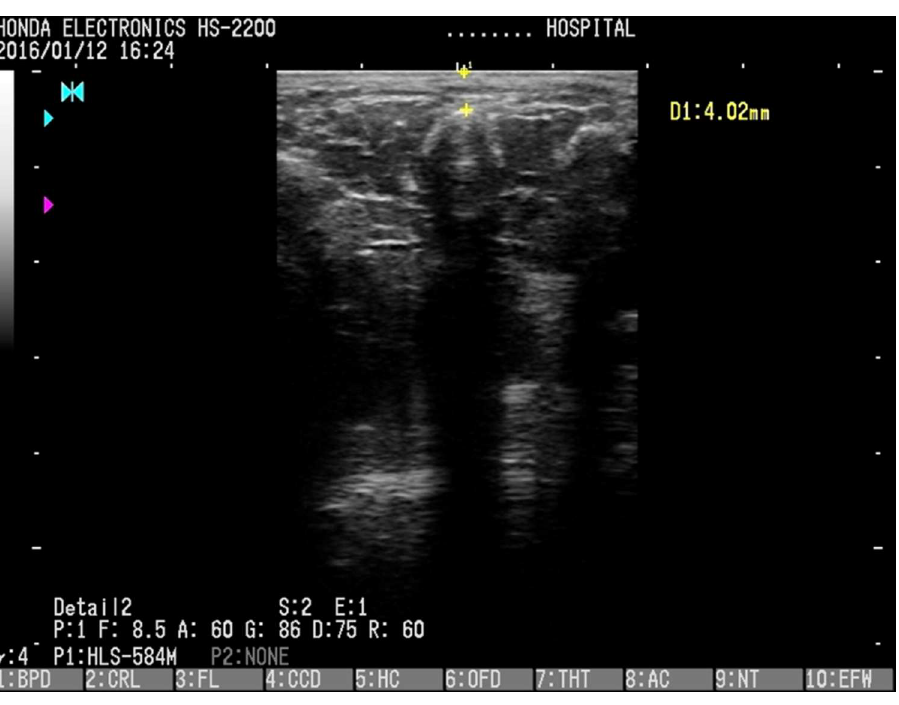
Fig 4. Measure of the thickness of the subcutaneous soft tissue by ultrasound